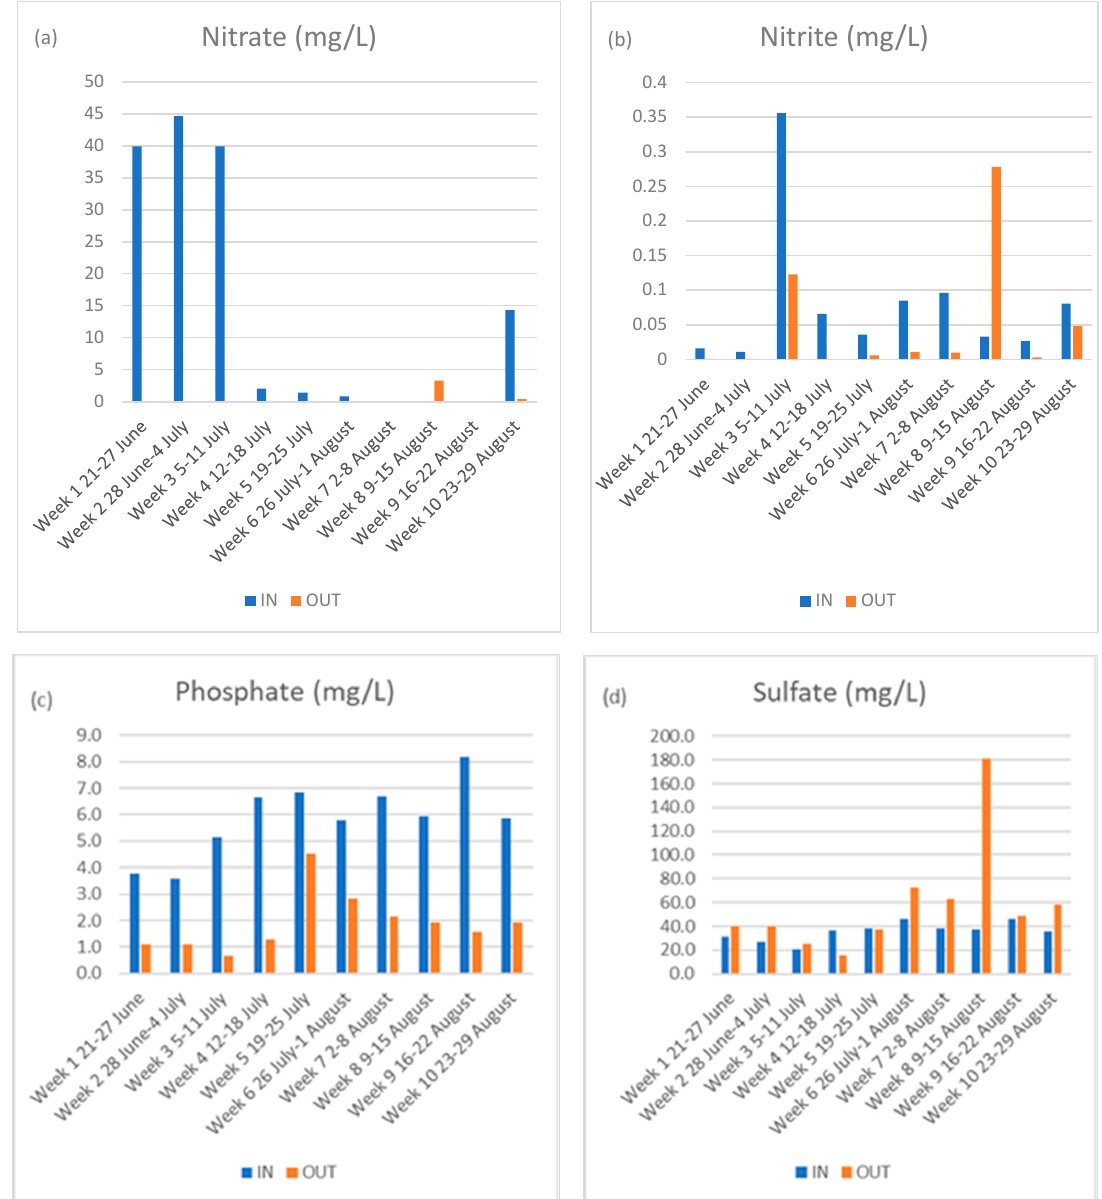
Figure 4. Time course evolution of nitrate ( a ), nitrite ( b ), phosphates ( c ), and sulfates ( d ). For nitrite, the concentrations along the wetland trail ranged from an average value of 0.35 mg L − 1 at the inflow site to 0.30 mg ∙ L − 1 at the outflow site, with a removal efficiency of 40% ( p < 0.456). However, the values of NO 3 − and NO 2 − differed significantly among the different sampling dates, as marked in Figure 4a,b. This variation might be attributed to several components, as the Litani River effluents contain excessive amounts of nitrogen, as a result of the agricultural runoff and agro-industrial wastewater typical of the Litani River Basin. Despite substantial variability in the degree and rate of nitrogen cycling under the influence of several variables, such as air temperature, level of dissolved oxygen, pH, and other environmental conditions, the probable elimination mechanisms of nitrate and ni- trite include plant and microbial assimilation, nitrification/denitrification phase, and po- tential release of volatile ammonia gas to the atmosphere [34]. The inflow NO 3 − concentrations (Table 1) fall within the range of the environmental limit values for surface water based on MoE Decision 8/1 [28]. Furthermore, the levels of NO 2 − found in the inflow samples were found to be lower than the guideline levels for protecting sensitive aquatic animals during short-term exposures [35]. On the other hand, outflow concentrations for both nitrate and nitrite remained relatively constant through- out the study, demonstrating high removal efficiency for nitrate (97.39%, p < 0.078) and nitrite (40%, p < 0.456). This was expected given the strong dependency of microbial deni- trification on temperature, which converts NO 2 − /NO 3 − to NO x and N 2 gases [36]. 4.2.3. Phosphate Figure 4c presents time course evolution of phosphate in water samples from both the wetland inflow and outflow during the sampling period. A significant decrease in phosphate concentration measured in the outflow was observed, compared to the inflow, with a removal efficiency of 67% (Table 3). Average concentration of phosphate along the wetland upstream and downstream ranged from 5.8 mg L − 1 to 1.9 mg ∙ L − 1 , respectively (Tables 1 and 2). The level of phosphate in the influent at all sampling dates were higher than the discharge limit of 5 mg L − 1 set by the Ministry of Environment [28]. Indeed, the concentrations of phosphates at the downstream site of the wetland ranged from 0.6 to 4.5 mg ∙ L − 1 and were higher compared to the values obtained from the upstream site. This